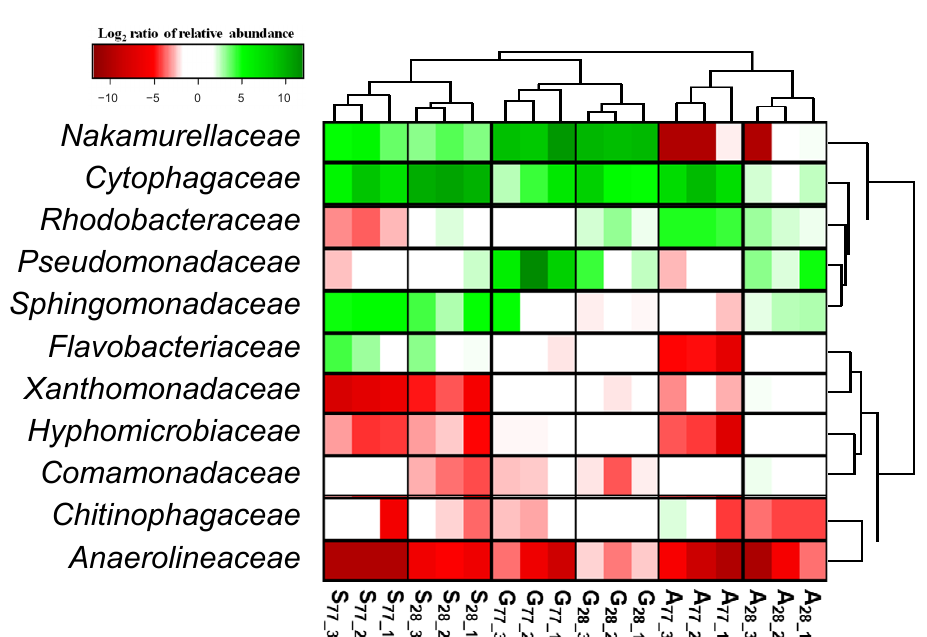
Figure 4. Major families of AS microcosm communities. Eleven major families (>2% of the total, on average) are shown. The Log 2 -transformed fold change (each community over the average of I) is shown by color. Negative/positive values of the Log 2 -transformed fold changes indicate decreased/increased taxa in relative abundance in each community compared to the I communities.